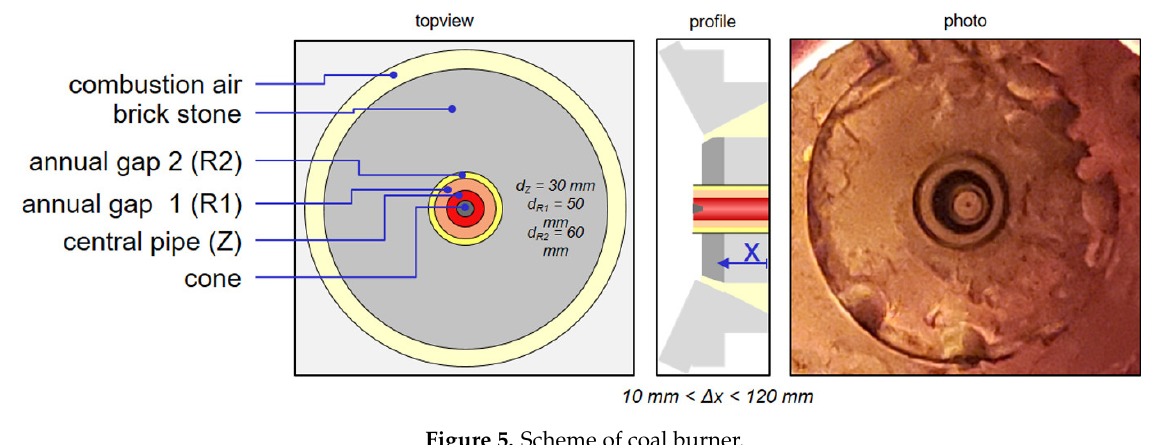
Figure 5. Scheme of coal burner.